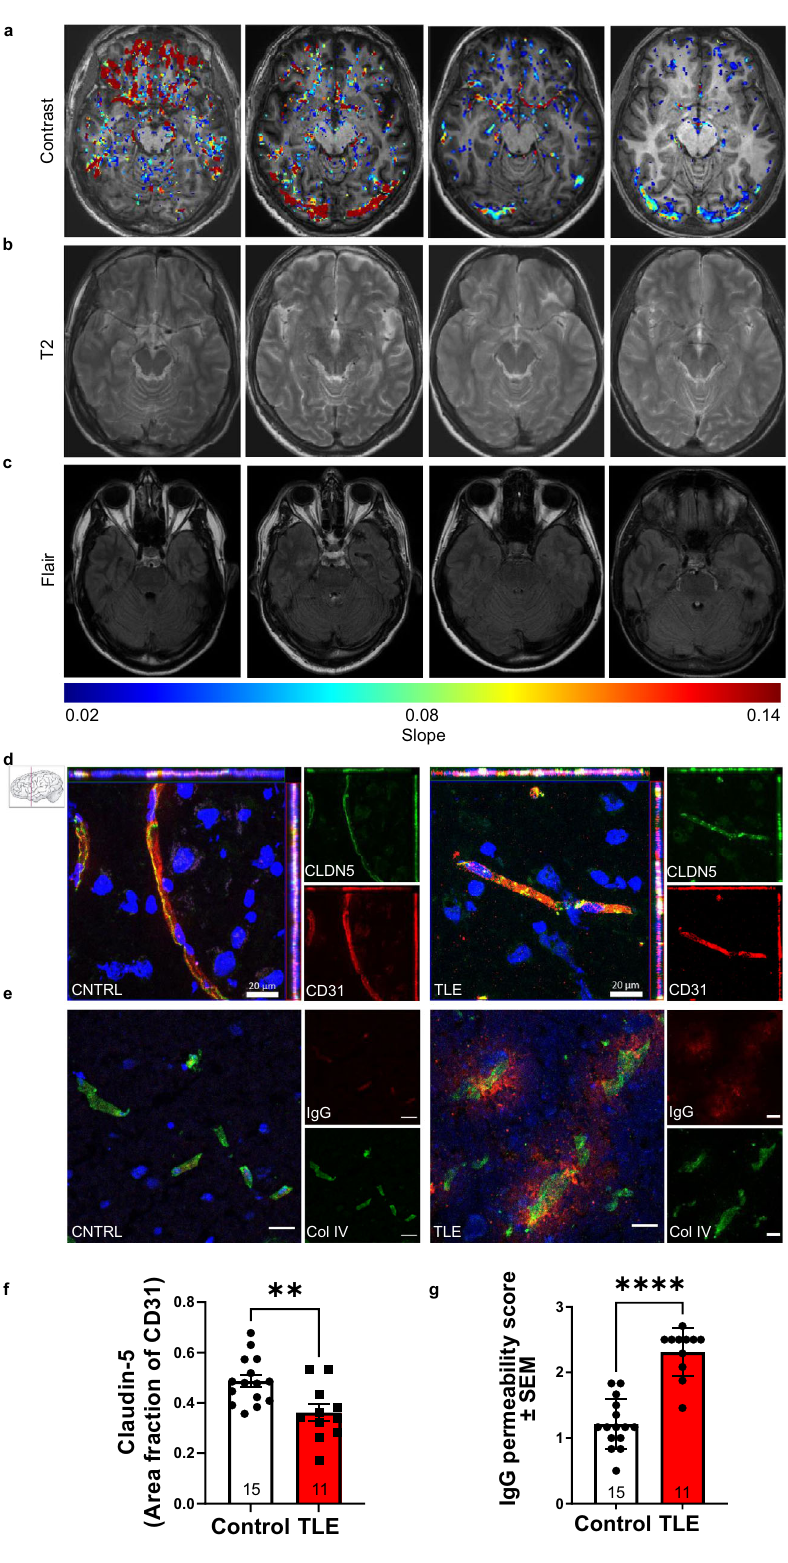
junction associated components Ocln (Fig. 2e) and Tjp1 (Fig. 2f) were also signi fi cantly decreased in the hippocampus in the acute phase post kainic acid injection. We next investigated brain-blood vascular leakage by assessment of the levels of the astrocytic protein S100 β which is a marker of BBB disruption and has previously been reported to be elevated in epilepsy 23 . Serum